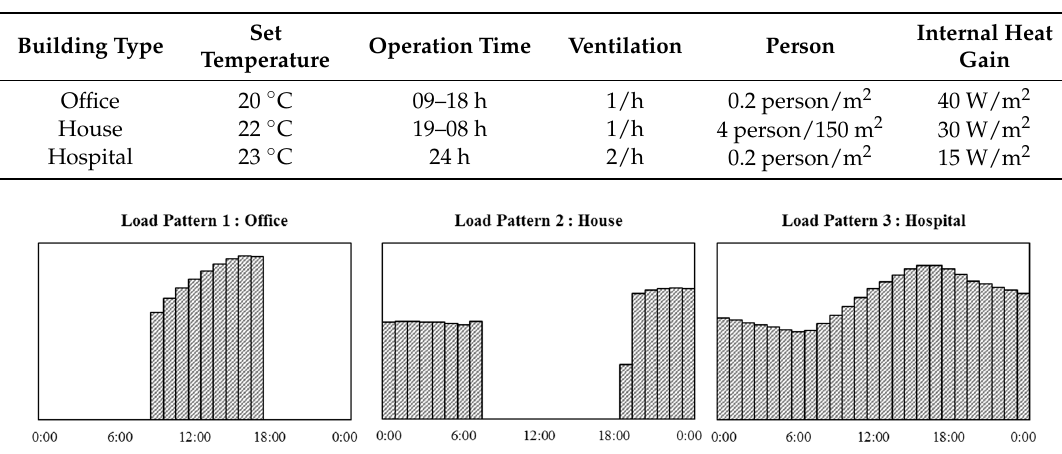
Figure 9. Three load patterns for example.